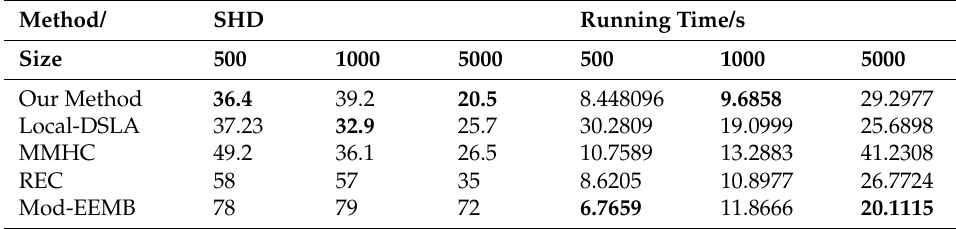
Table 3. Results for data Child5.